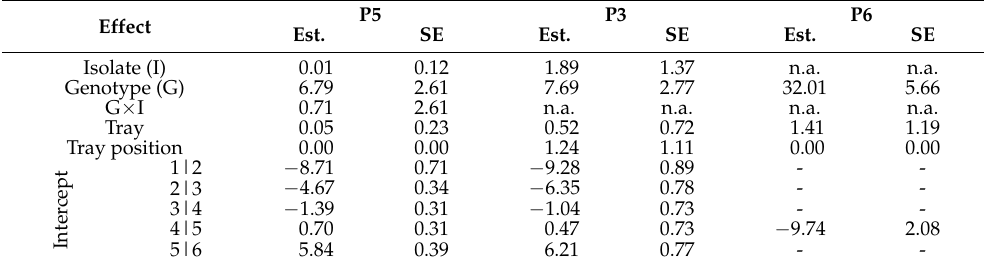
Figure 6. Correlation of genotype means stem rust resistance assessed in the field ( x -axis) and in the seedling stage ( y -axis) of P3 ( left ) and P5 ( right ). Table 6. Variance components and intercept estimates (Est.) with standard errors (SE) for populations P3, P5, P6 analysed for stem rust with seedling test and estimated by means a cumulative mixed logit